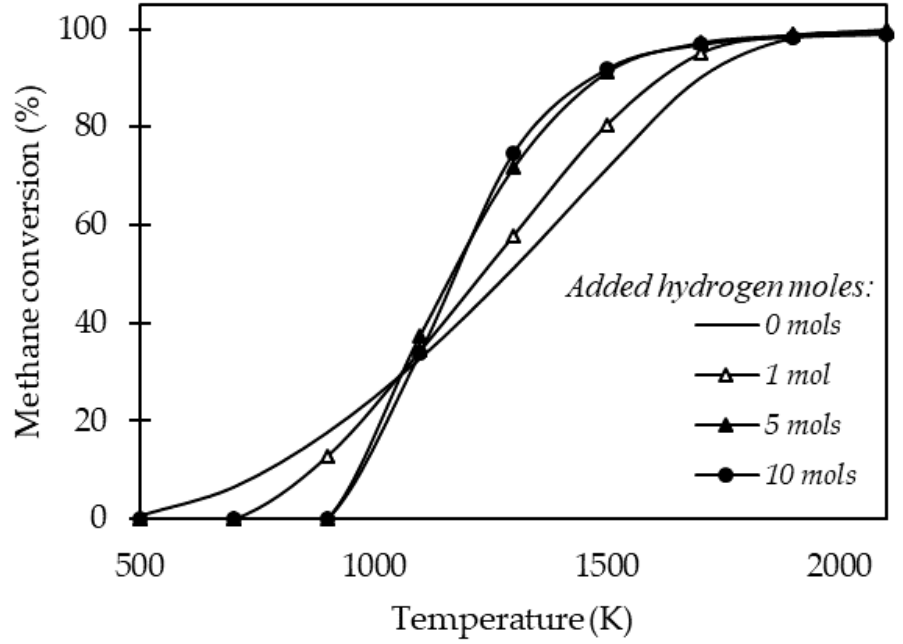
Figure 11. Effect of hydrogen addition on the methane cracking process at 1 atm.